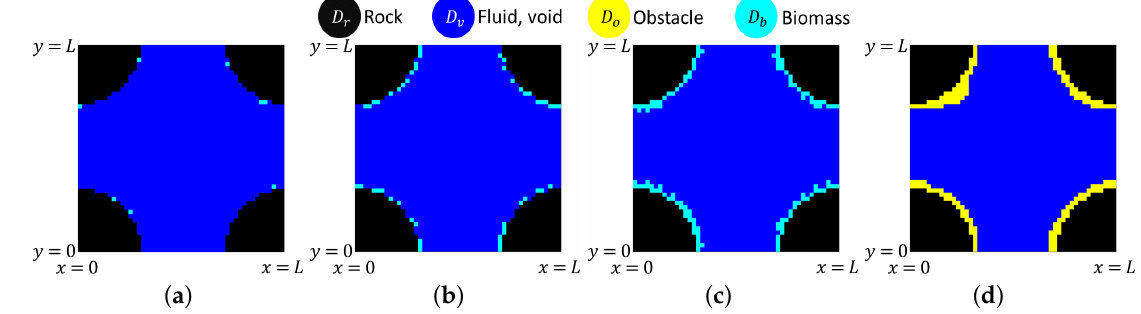
( i ) Figure 13. Realization of D used in DNS results: ( a ) V b = 0.0045, B 0 = 0.6 B ∗ for Figure 16, ( b ) V b = 0.03, B 0 = 0.8 B ∗ for b Figure 17, ( c ) V b = 0.07, B 0 = 0.6 B ∗ for Figure 18, ( d ) V b = 0.1, B 0 = B ∗ for Figure